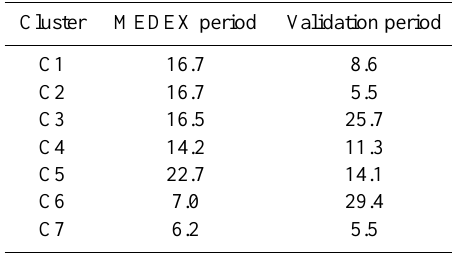
Table 2. Frequency (in %) of strong wind events for each cluster and for the MEDEX and validation